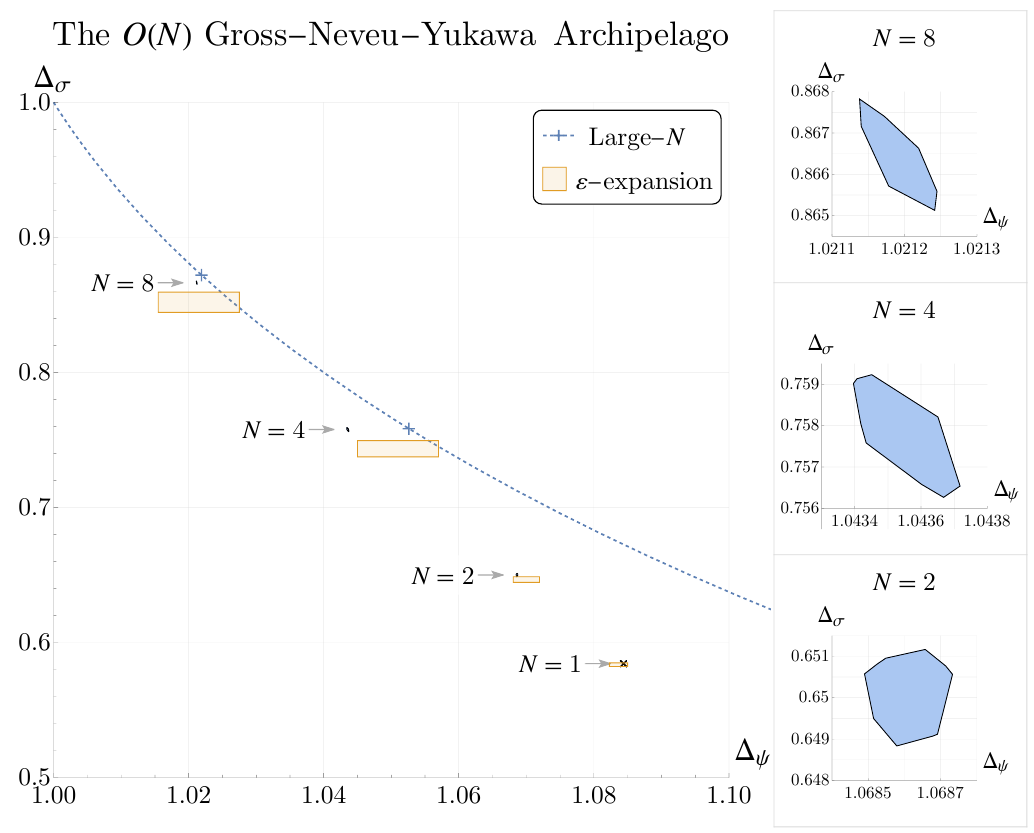
Figure 1 . A compilation of our N = 2 , 4 , 8 islands at n max = 18 , projected onto the (∆ ψ , ∆ σ ) plane, compared against the perturbative estimates in the large- N expansion (represented by the dotted blue curve), Borel-resummations of the (4 − (cid:15) ) -expansion [31] (represented by the orange boxes), and the location of the N = 1 island from the N = 1 supersymmetric Ising bootstrap [42–44] (represented by the